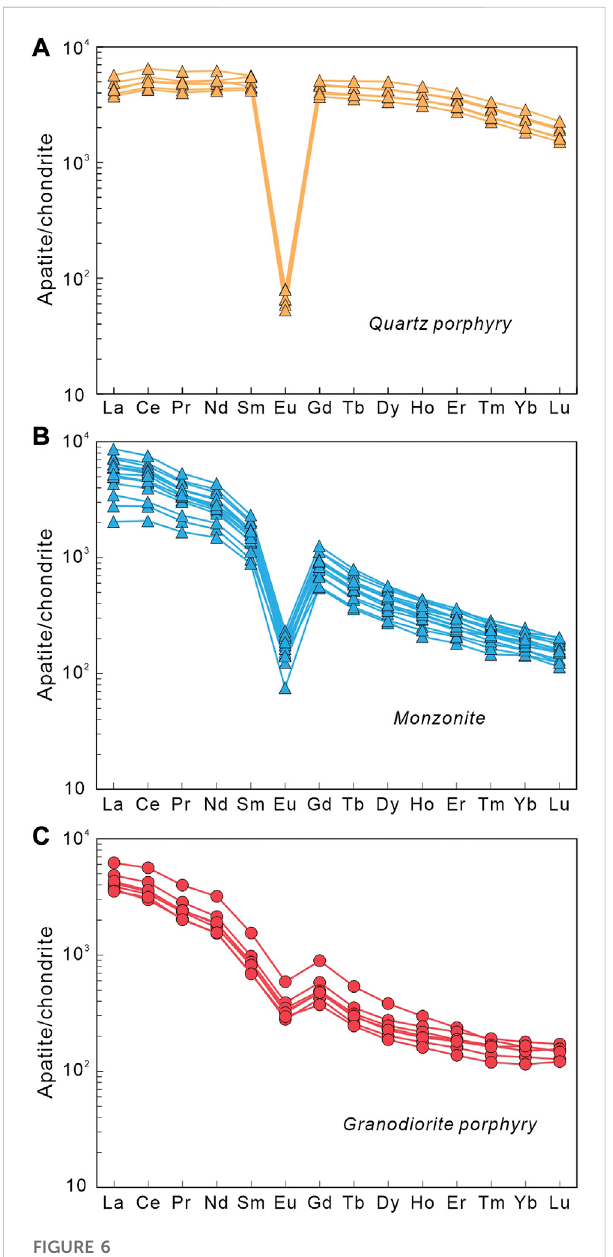
FIGURE 6 (A – C) Chondrite-normalized REE patterns of apatite from quartz porphyry, monzonite, and granodiorite porphyry of the Kalmakyr deposit. Chondrite normalization values are from Sun and McDonough (1989).